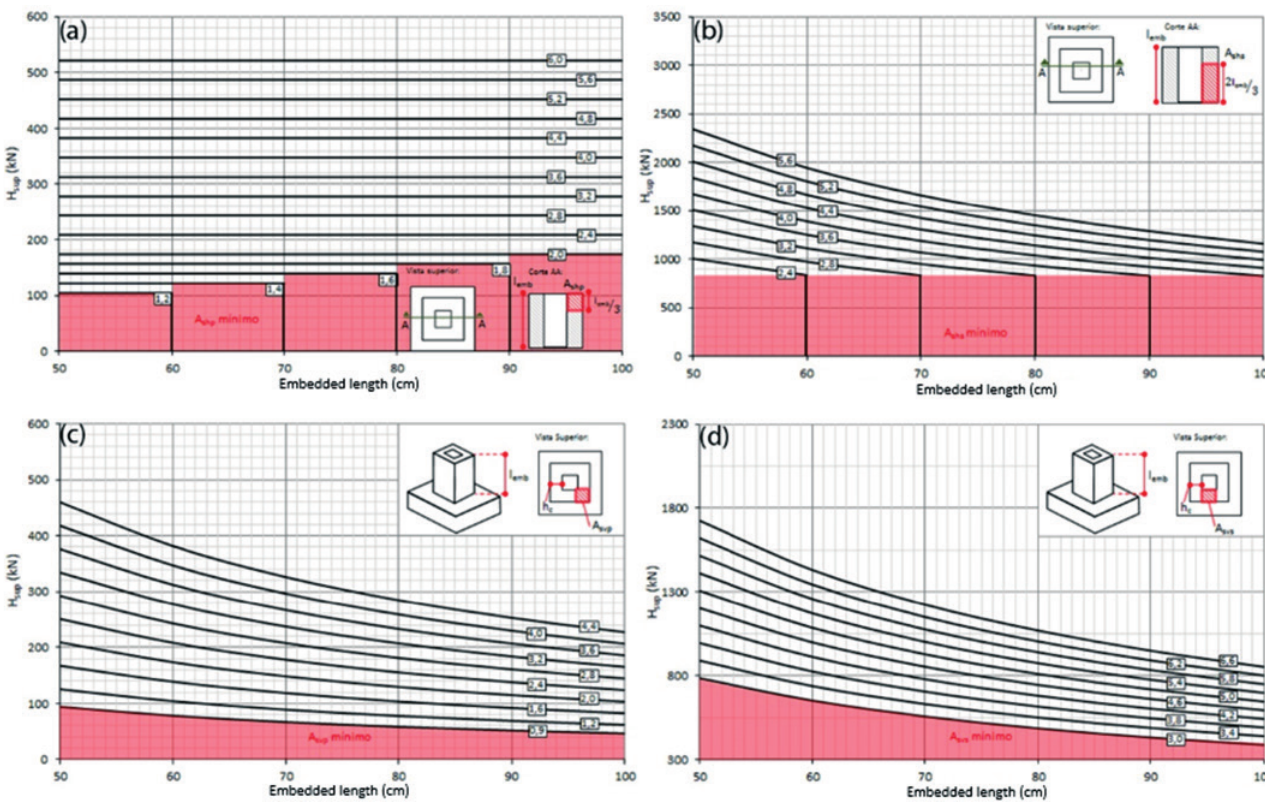
Abacus for calculating of the reinforcements (cm 2 ) for a socket base with wall thickness equals to 15 cm, column section of 25 x 25 cm 2 , a C25 concrete and a CA-50 steel socket is necessary to define the optimal geometry of the socket